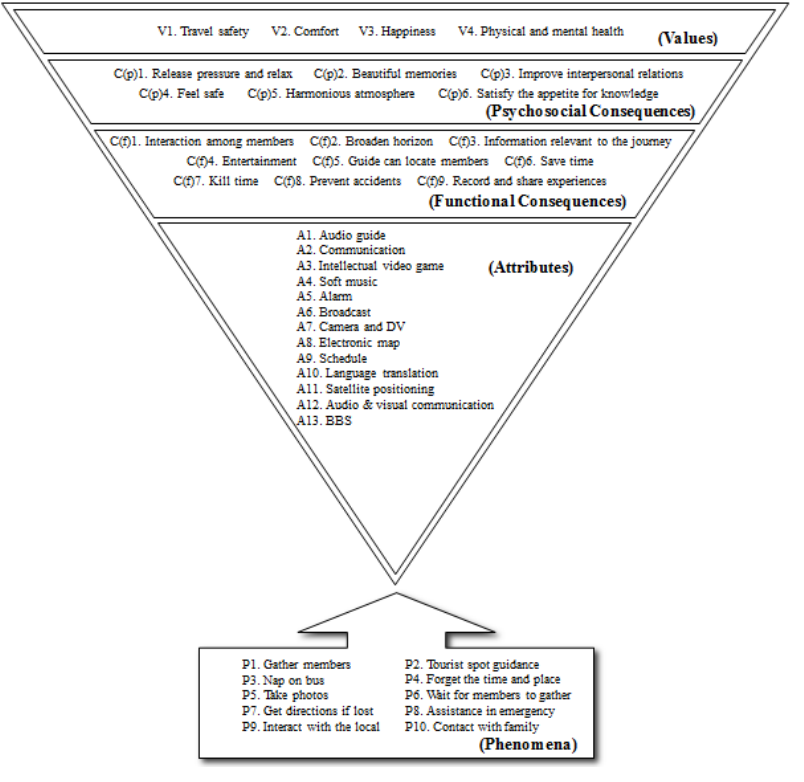
Figure 4. Summary content codes (*Consequences are categorized into C(f) and